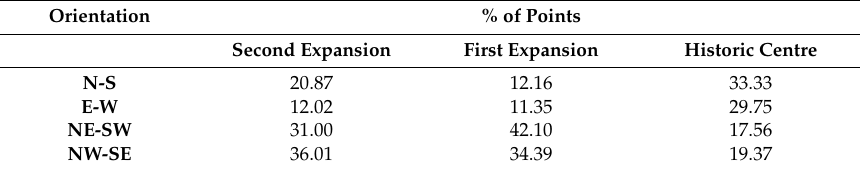
Figure 11. ( a ) Comparison of street areas. ( b ) Comparison of street widths. Table 2. Comparison of street orientations.